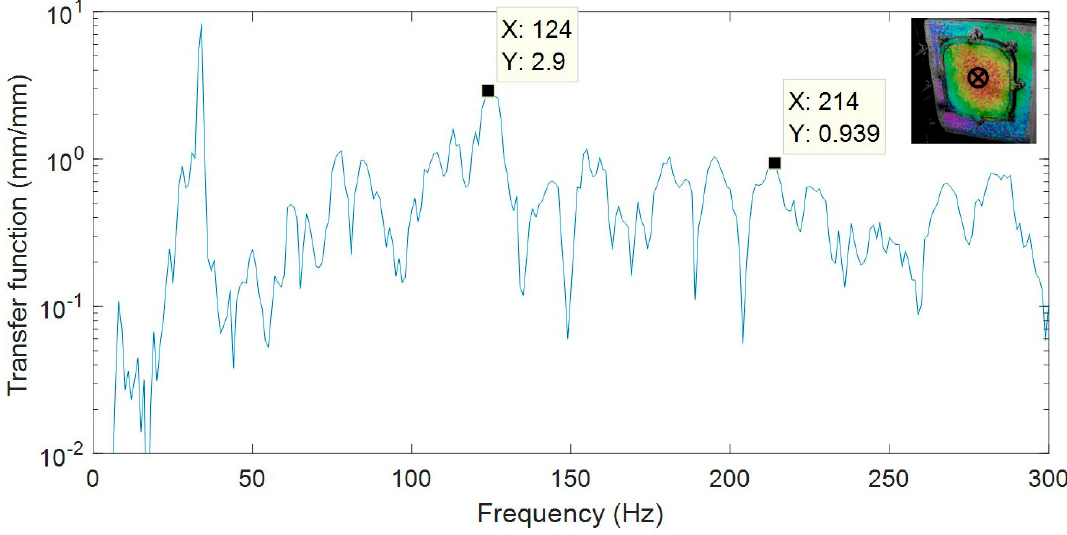
Figure 12. Transfer function of a point from the center of the window using HS 3D-DIC.